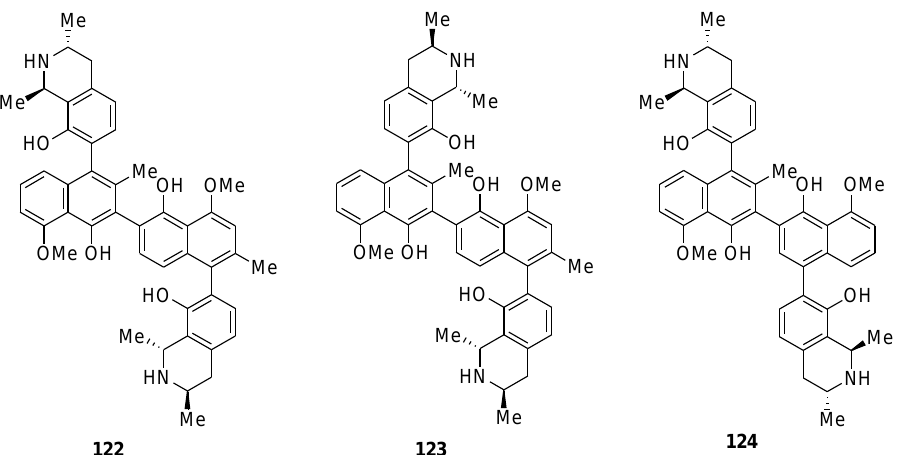
Figure 23. Representation of the naphthylisoquinoline dimers jozilebomines A ( 122 ), jozilebomines B ( 123 ), and jozimine A 2 ( 124 ).